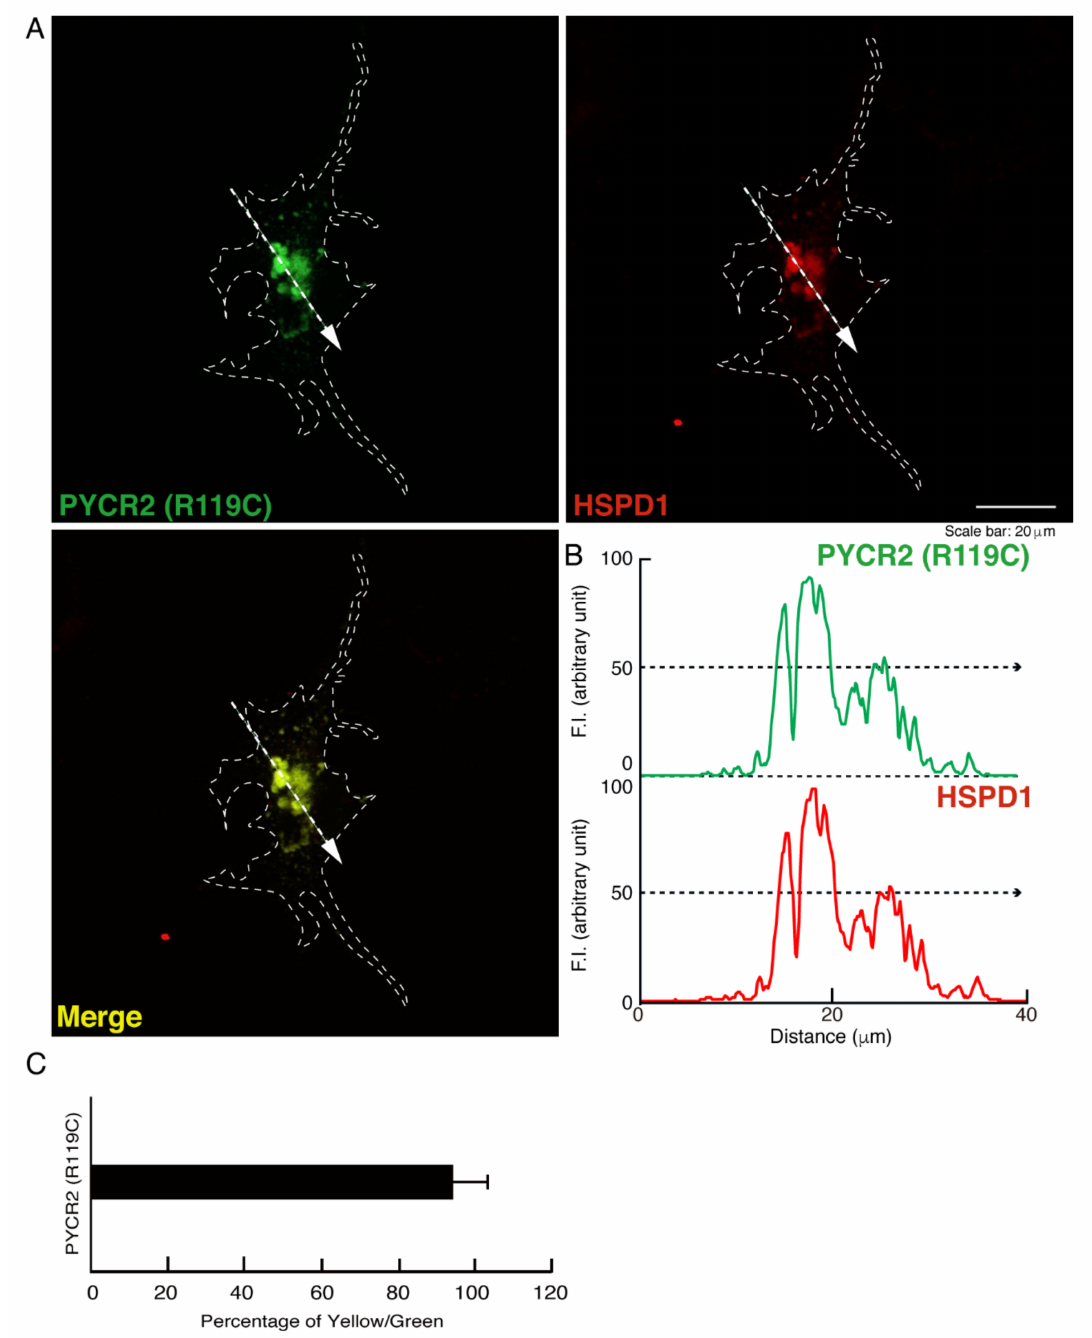
Figure 3. The R119C proteins are significantly co-localized with the large size mitochondria. ( A , B ) COS-7 cells were transfected with the plasmid encoding the GFP-tagged PYCR2 R119C and stained with an antibody against the mitochondrion-specific antigen HSPD1 (red). GFP-tagged PYCR2 R119C proteins were identified by their green fluorescence color. The approximate outline of the cell is surrounded by white dotted lines. Scan plots were performed along the white dotted lines in the direction of the arrows in the color images (green and red as well as merged images). Graphs showing the fluorescence intensities (F.I., arbitrary units) along the lines in the direction of the arrows were depicted in the right bottom panels. ( C ) Percentage of merged yellow fluorescence pixel values per green fluorescence ones are shown in the